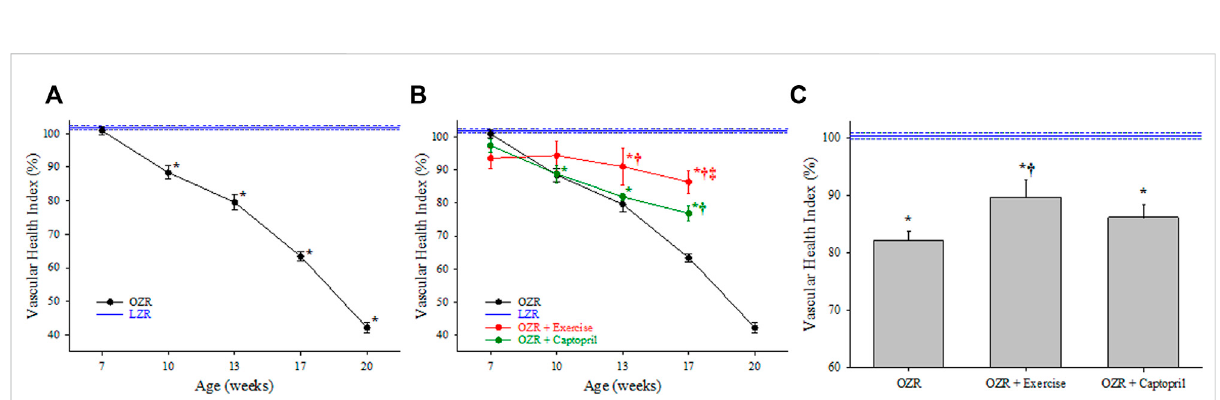
FIGURE 3 Data describing the 3-parameter determination of Vascular Health Index (VHI) within the peripheral/skeletal muscle microcirculation. Data (mean ± SE) are presented for OZR over the age ranges of the present study (Panel (A) ) or the impact of chronic interventions with either exercise or captopril administration (Panel (B) ). Panel (C) presents the aggregate VHI from the different animal groups where all ages have been compiled into onedatapoint.VHIfromLZRissetto100%,byde fi nition.* p < 0.05vs.LZRatthatage; † p < 0.05vs.untreatedOZRatthatage. ‡ p < 0.05vs.OZR+ captopril at that age. Please see text for